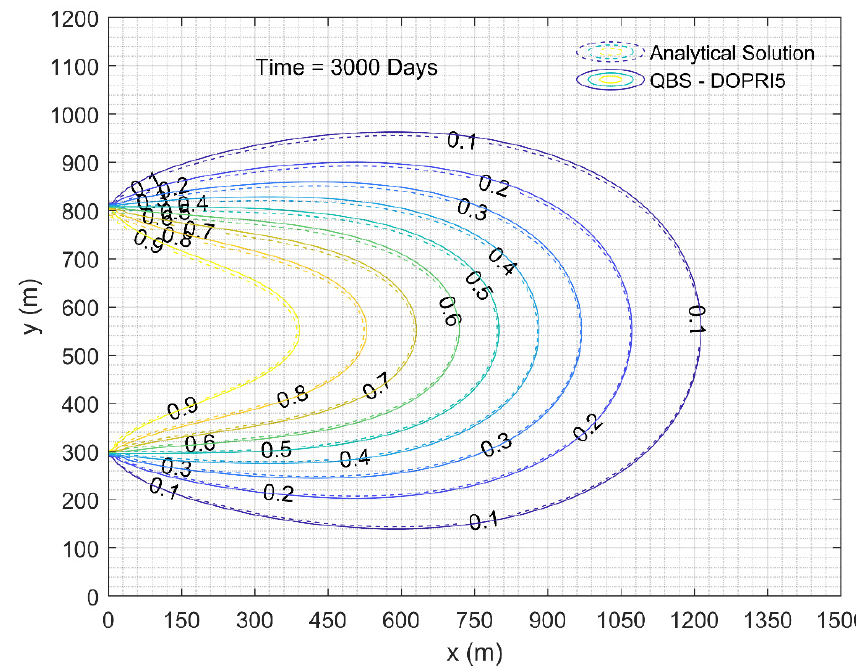
Figure 4. Comparison of approximate solution obtained with QBS-DOPRI5 and analytical solution at time = 3000 days ( ∆ x = 20 m, ∆ y = 16 m ) .